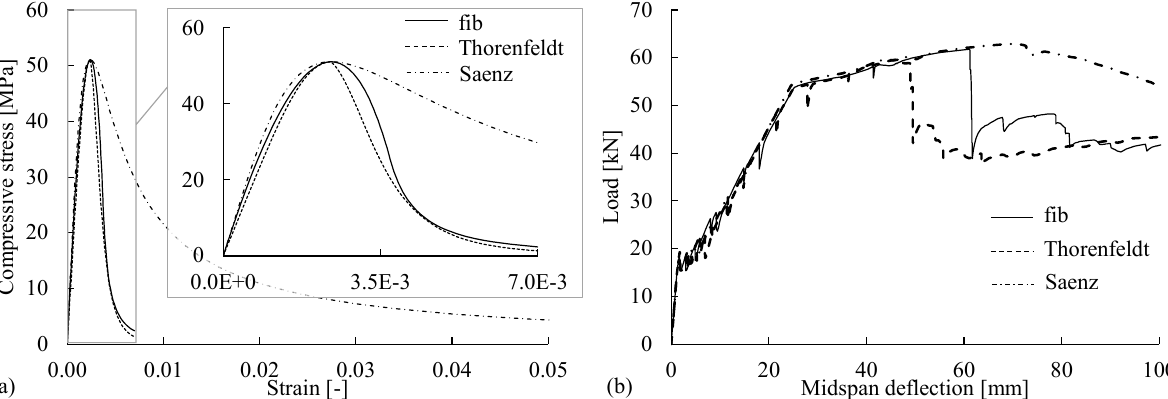
Figure 15. ( a ) Stress–strain models—Model Code [14,15], Thorenfeldt [21], and Saenz [51]—for the concrete compressive behavior with different post-peak softening branches; ( b ) load–deflection curves for FE analyses based on the stress–strain models without modification.